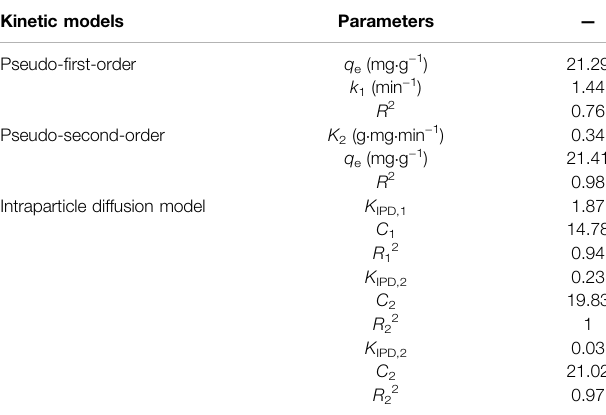
TABLE 2 | Kinetic parameters of PMBN3 adsorption towards